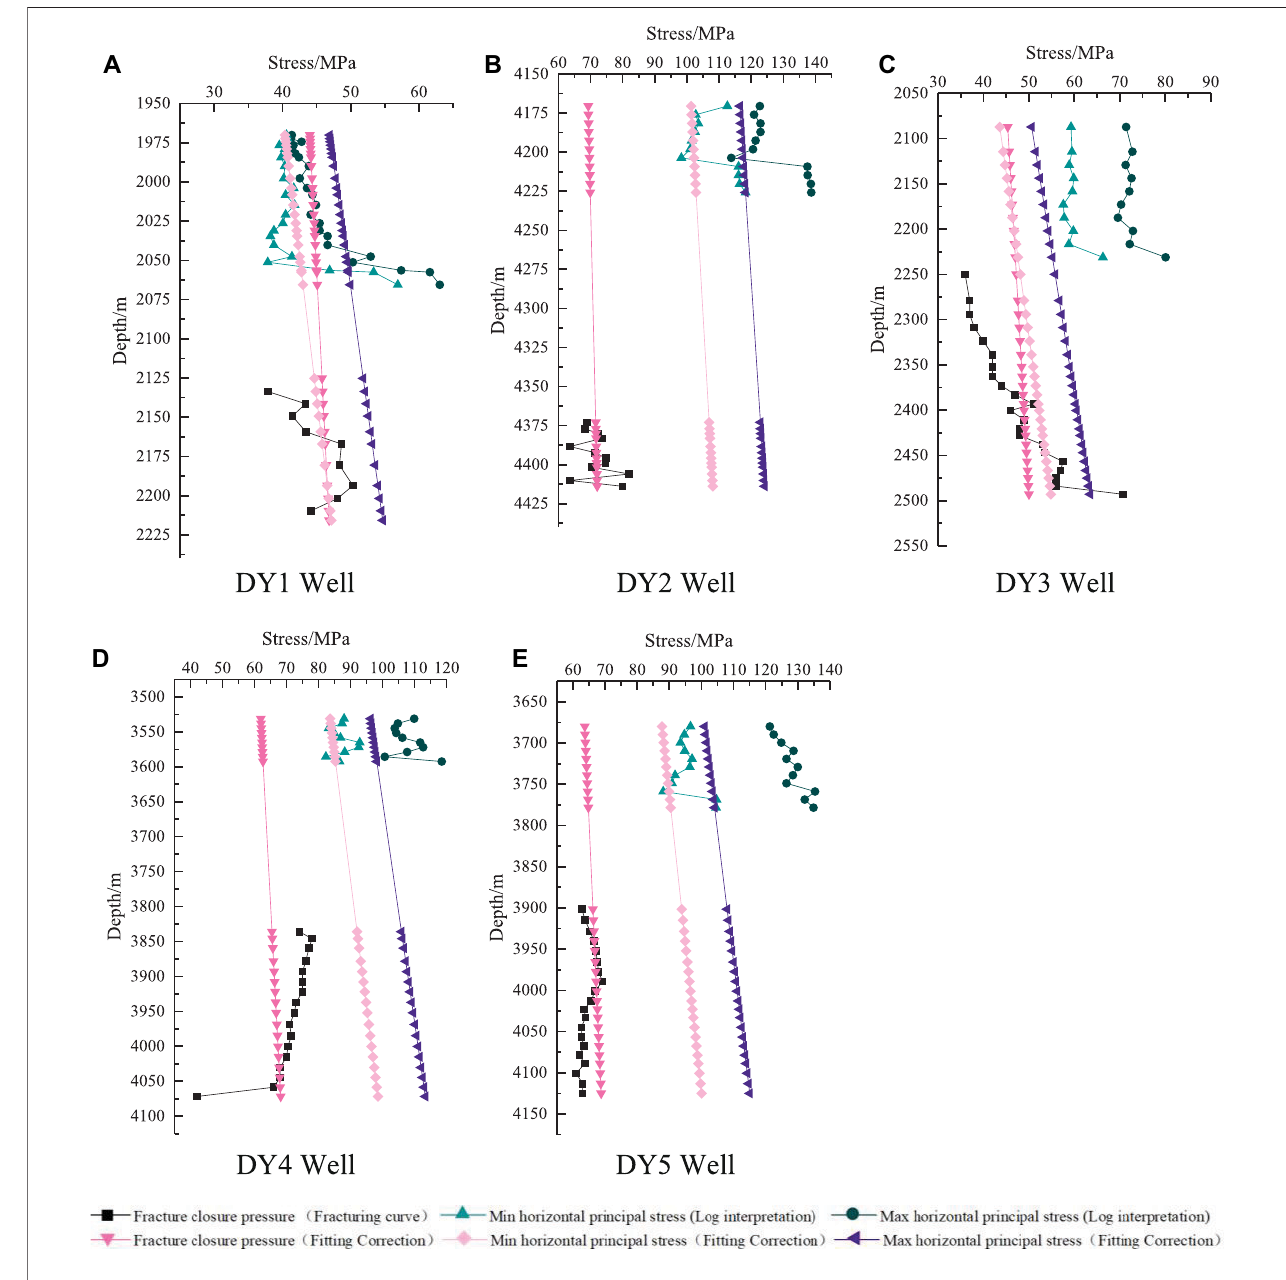
FIGURE 7 | Stress vertical section of Dingshan area. (A) DY1 Well. (B) DY2 Well. (C) DY3 Well. (D) DY4 Well. (E) DY5 Well.